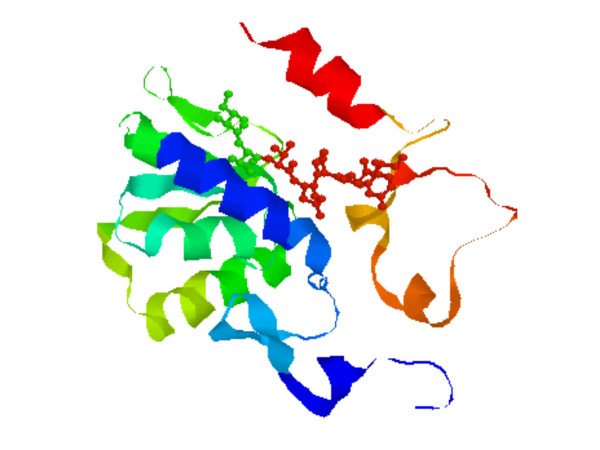
Homology model of Bfl499 protein. (template:1NV8; HemK Protein from Metanococcus jannaschii). Sensitive sequence alignment algorithms predict this protein to be a N-6 adenine specific DNA methylase or general S-adenoslmethonine-dependent methyltransferase by similarities to experimentally well characterized proteins such as the close relative E.coli. Moreover, for the homologue in M.jannaschii the three dimensional structure is known. This allows to establish the homology model shown here. Details of the structure: The N6-methylase prosite motif IItNPPY, residues 121 to 127, is highlighted in ball and stick. The fold consists of 3 layers, a/b/a; forming a mixed beta-sheet of 7 strands, order 3214576; strand 7 is anti-parallel to the rest. The homology of the Bfl499 protein does not include the additional helical domain present in 1NV8.